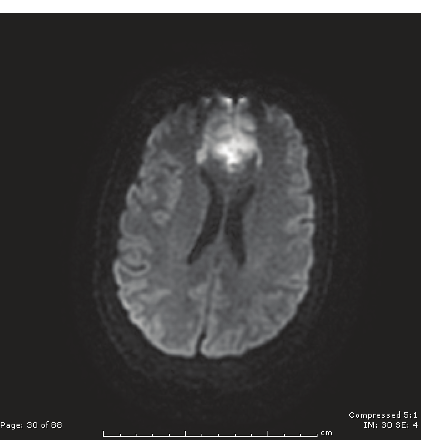
Figure 1: DWI MRI showing restricted diffusion bilateral ACA ter- ritory.